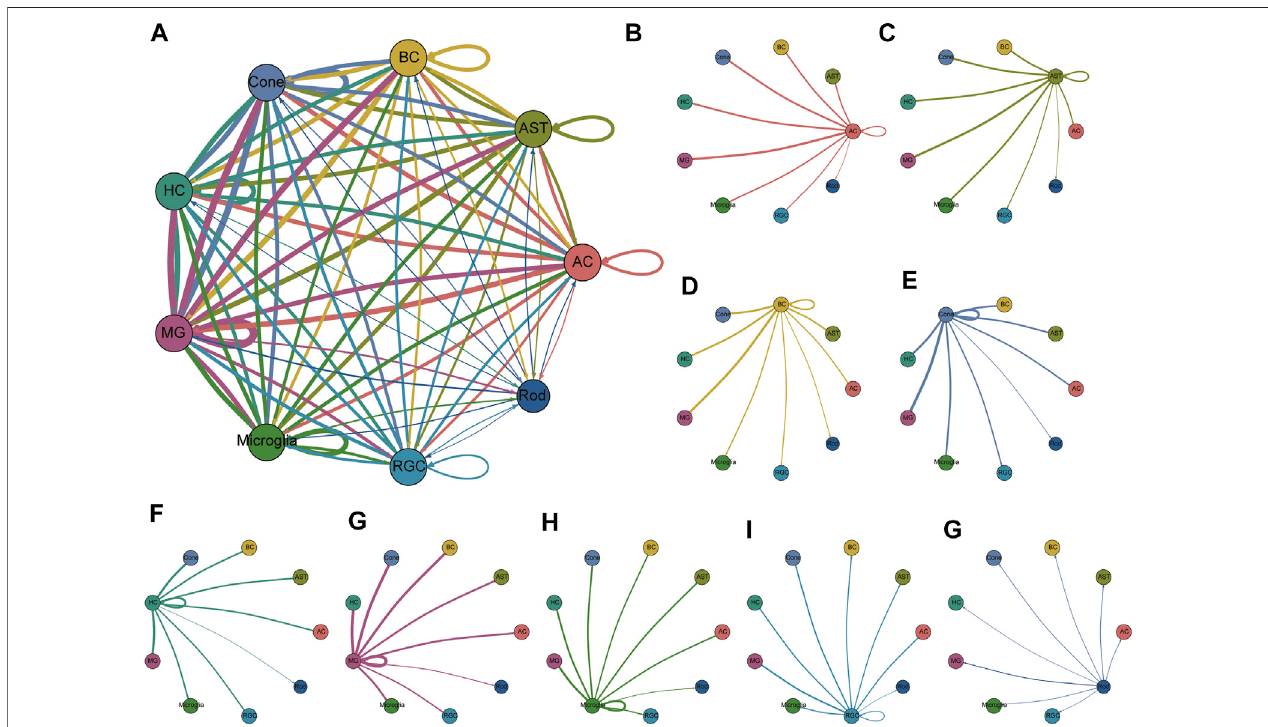
FIGURE 4 | Communication network of all clusters and communication networks separated by clusters. (A) Overall cellular communication network. Nodes with differentcolorsrepresentdifferentcelltypes,andlinesrepresentpotentialreceptor-ligandinteractionsbetweenthetwocelltypes.Thelinethicknessisproportionaltothe number of ligands where cognate receptors are present in the recipient cell population, and it can be regarded as the interaction strength. Lines with fewer than 1 interaction are not shown. The speci fi c receptor-ligand pair information is shown in Supplementary Table S4 . (B – G) The interactions of each cell type with the other cell types are shown